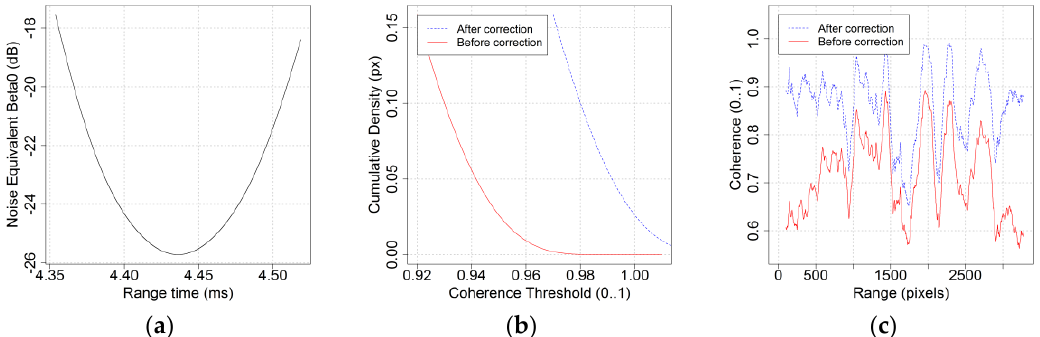
Figure 6. An example of ( a ) the noise floor polynomial, ( b ) the cumulative coherence distribution before and after residual error correction and ( c ) a range cut of the coherence across a November 2015 image.